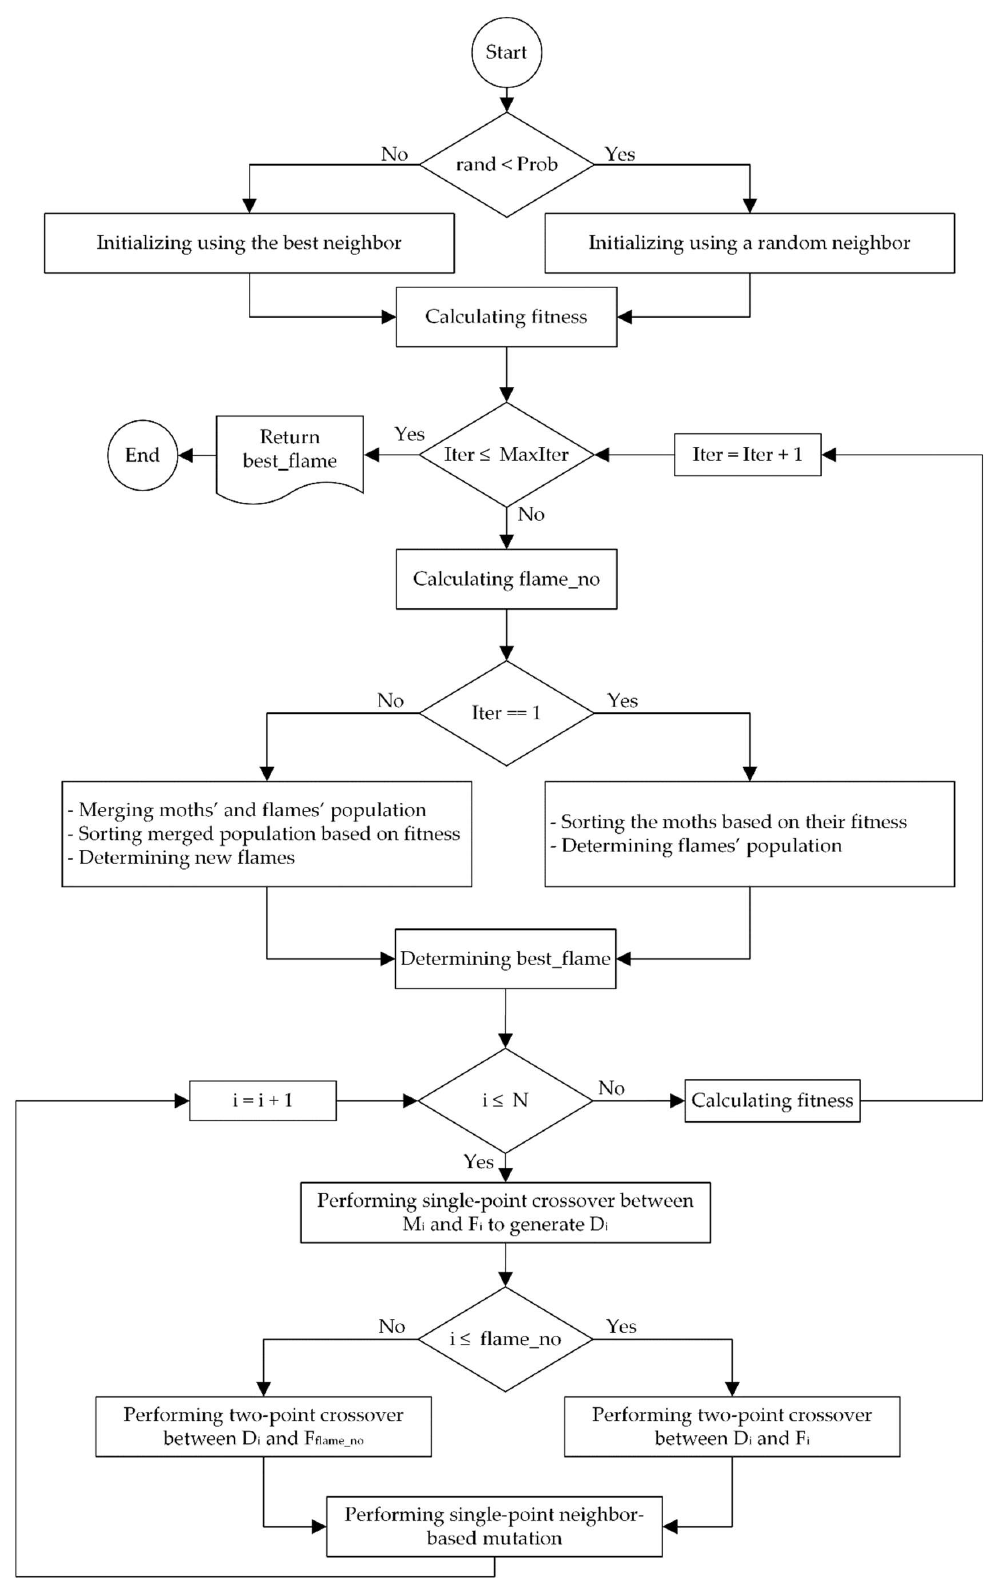
Figure 3. The flowchart of DMFO-CD algorithm.